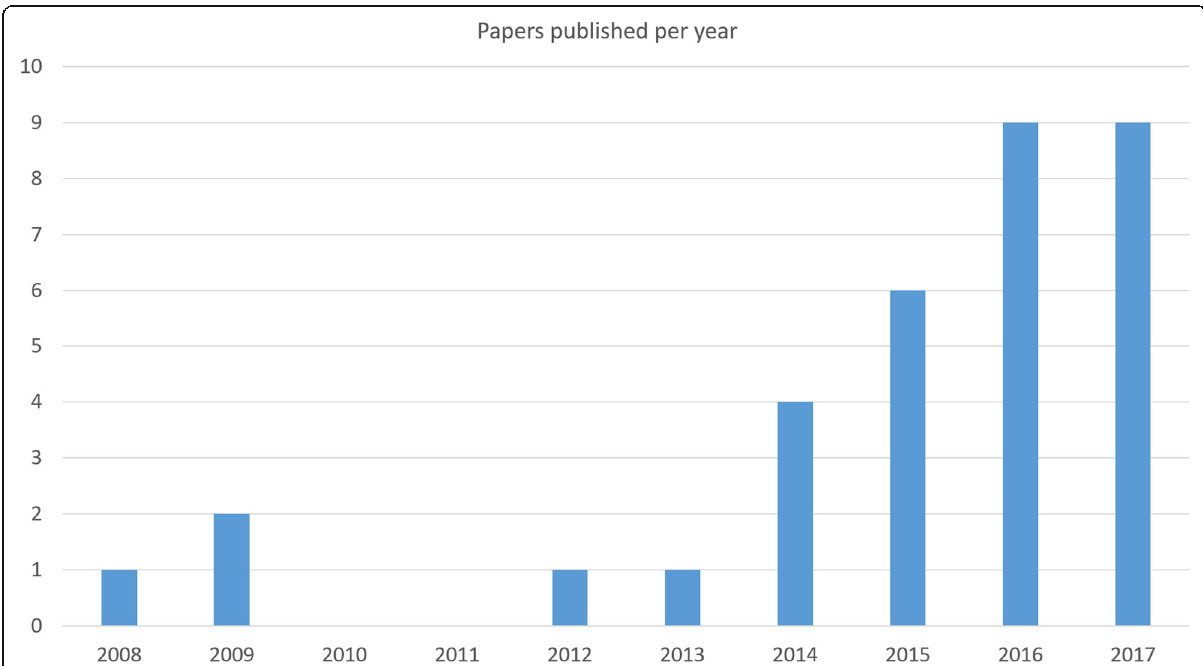
Fig. 1 Number of publications on 3D printing in the application of cardiac valve assessment or replacement